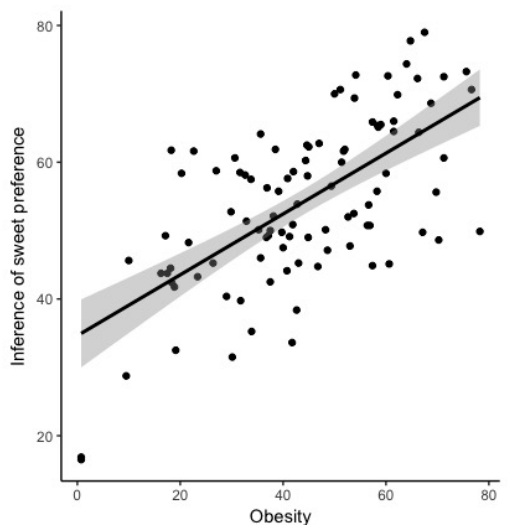
Figure A1. Scatterplot of the relationship between perceived obesity and inferences of sweet preference.